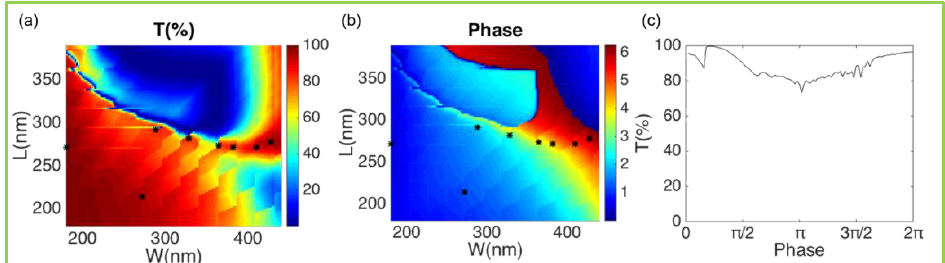
Figure 2. Design of meta-atoms. ( a ) Transmittance for nanoblocks on silica substrate as function of nanoblocks’ width W and length L with H = 132 nm and P = max(W,L) + 90 nm. ( b ) Corresponding phase variation of transmitted light through nanoblocks. ( c ) The highest transmittance achieved by the nanoblocks in the 0–2 π full-phase space. The period P keeps constant max(W,L) + 90 nm. The black star markers indicate the eight meta-atoms selected to construct metasurfaces.